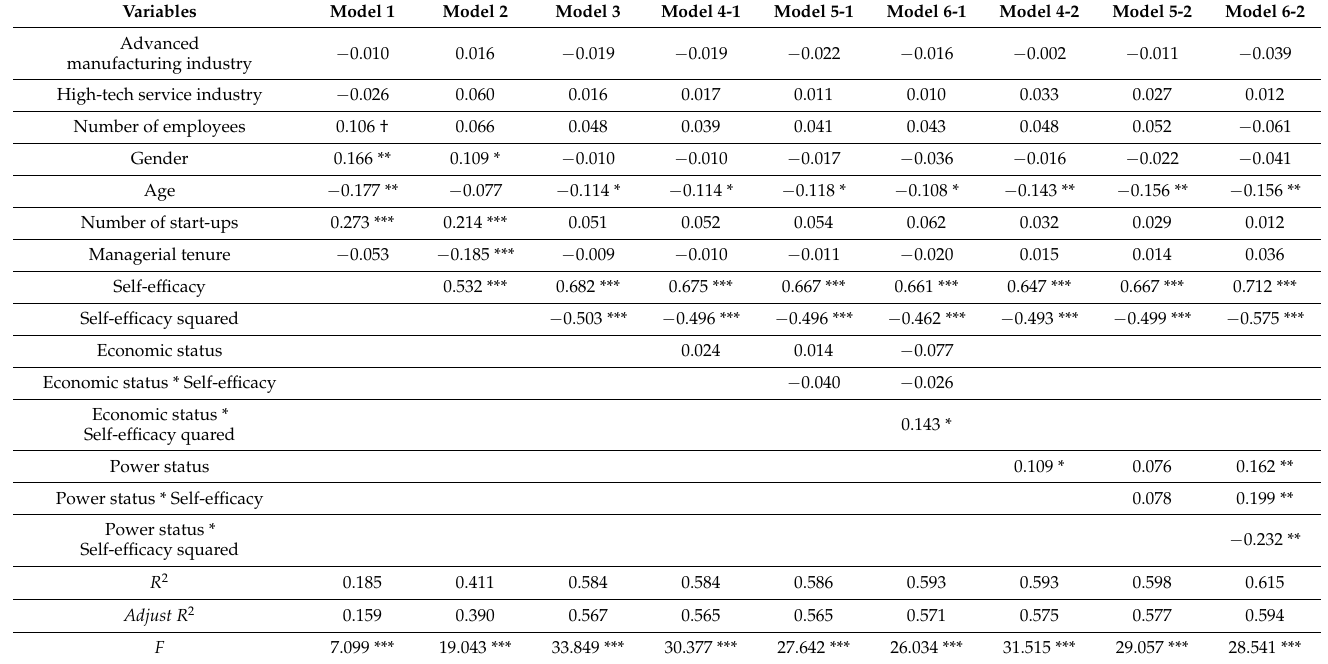
Table 3. Results of regression analyses of entrepreneurs’ ambidextrous